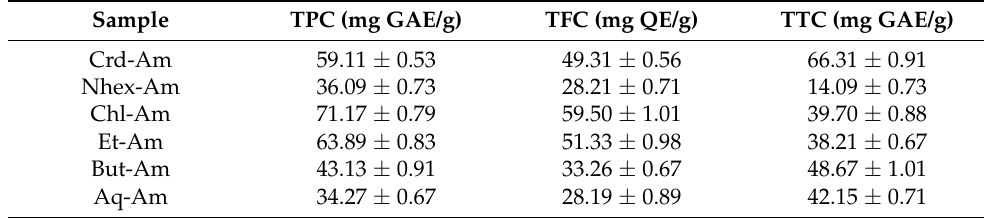
Table 1. Spectrophotometric quantitative phytochemical analysis of crude extract and fractions.